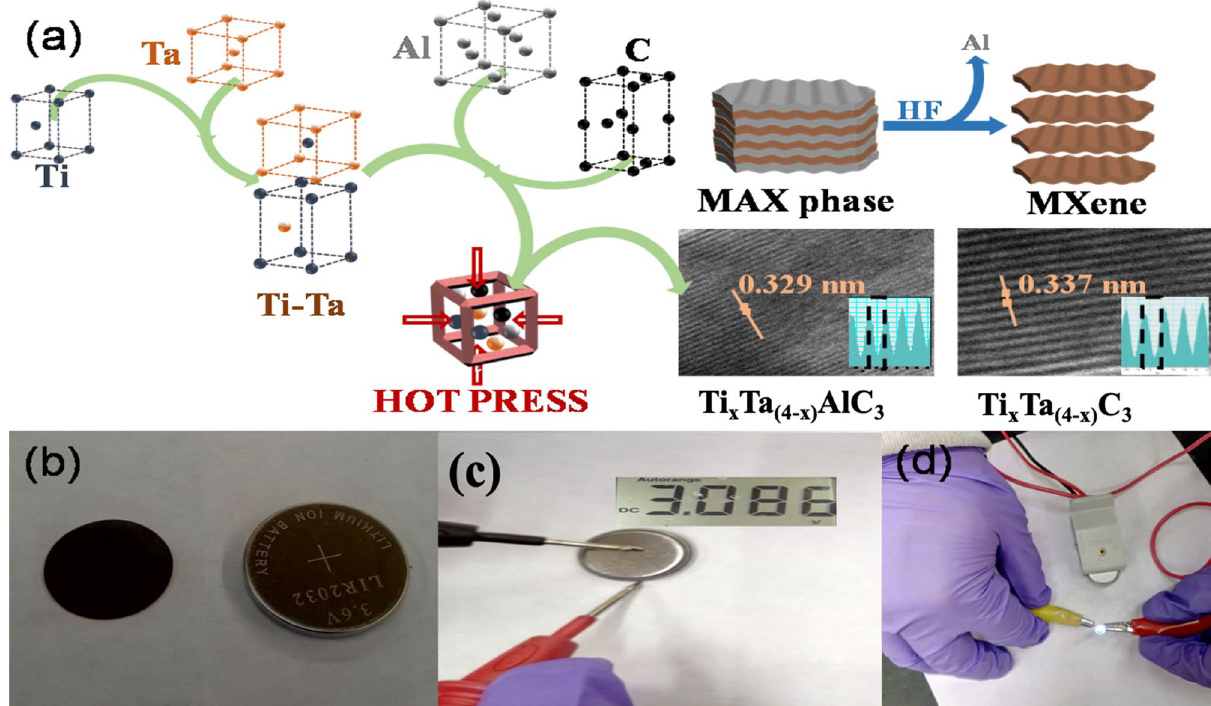
Figure 1. ( a ) A schematic illustration of the method followed to prepare bi-metallic Ti x Ta (4−x) C 3 MXene, ( b ) MXene working electrode and its respective coin cell; tests of ( c ) open circuity voltage and ( d ) LED emitting white light using our MXene